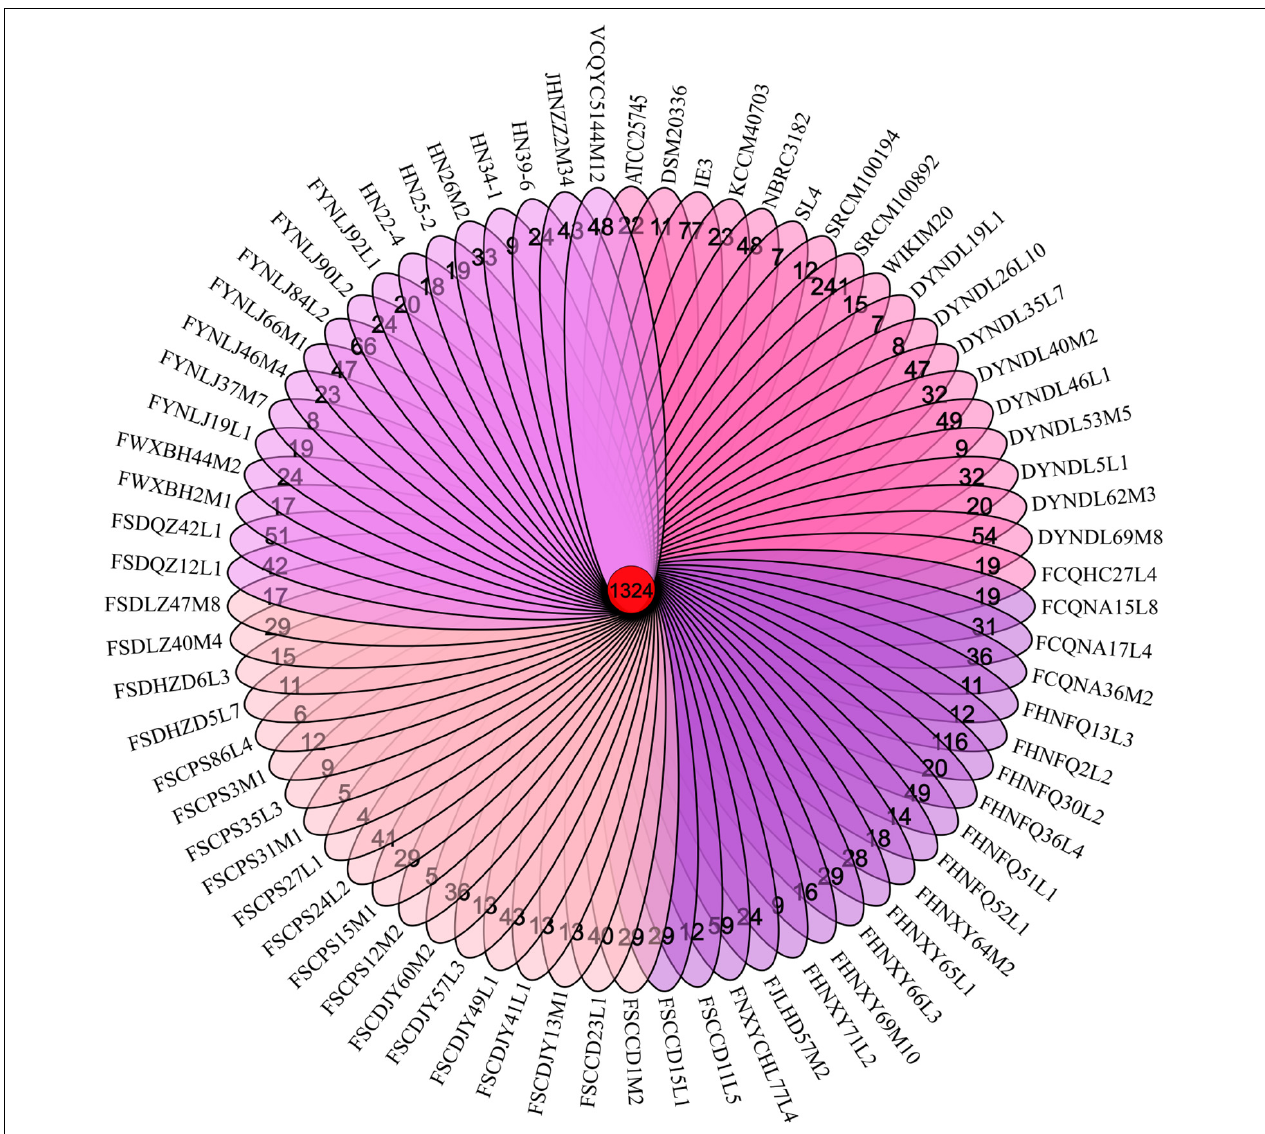
FIGURE 3 | Venn diagram. Venn diagram obtained by MCL clustering displaying core gene families, and unique genes of 74 P. pentosaceus.